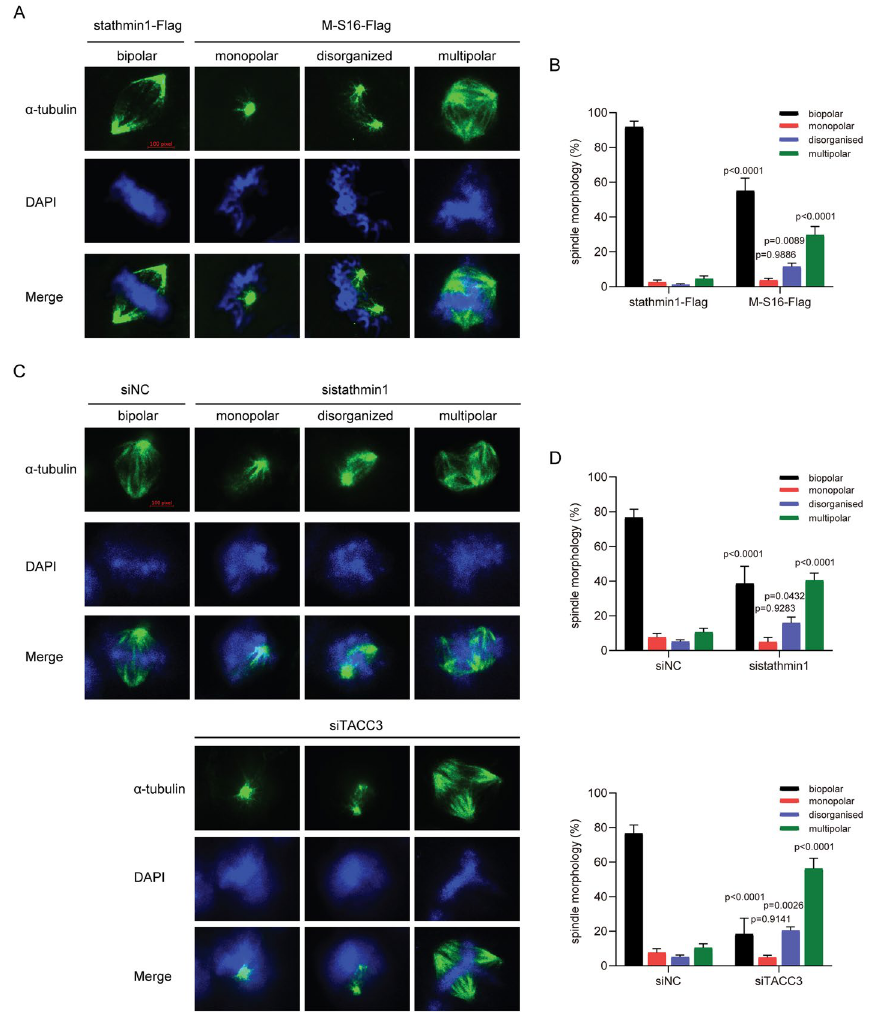
Fig. 7 Stathmin1 mutation at Ser16 or depletion of stathmin1 or TACC3 induces the formation of aberrant spindles. A Induction of multipolar and disorganized spindles in DLD1 cells transfected with a plasmid expressing a Ser16-mutated or wild-type stathmin1. After transfection for 48 h, the cells were fixed and stained with antibody to α-tubulin and DAPI. Bar, 10 pixels. B Quantification of the numbers of aberrant spindles in the DLD1 cells described in A . One hundred cells in each group were counted. C Induction of multipolar and disorganized spindles in HCT116 cells transfected with stathmin1, TACC3, or non-specific siRNA. After transfection for 48 h, cells were fixed and stained with antibody to α-tubulin antibody and DAPI. Bar, 10 pixels. D Quantification of the number of aberrant spindles in the HCT116 cells described in C . One hundred cells in each group were